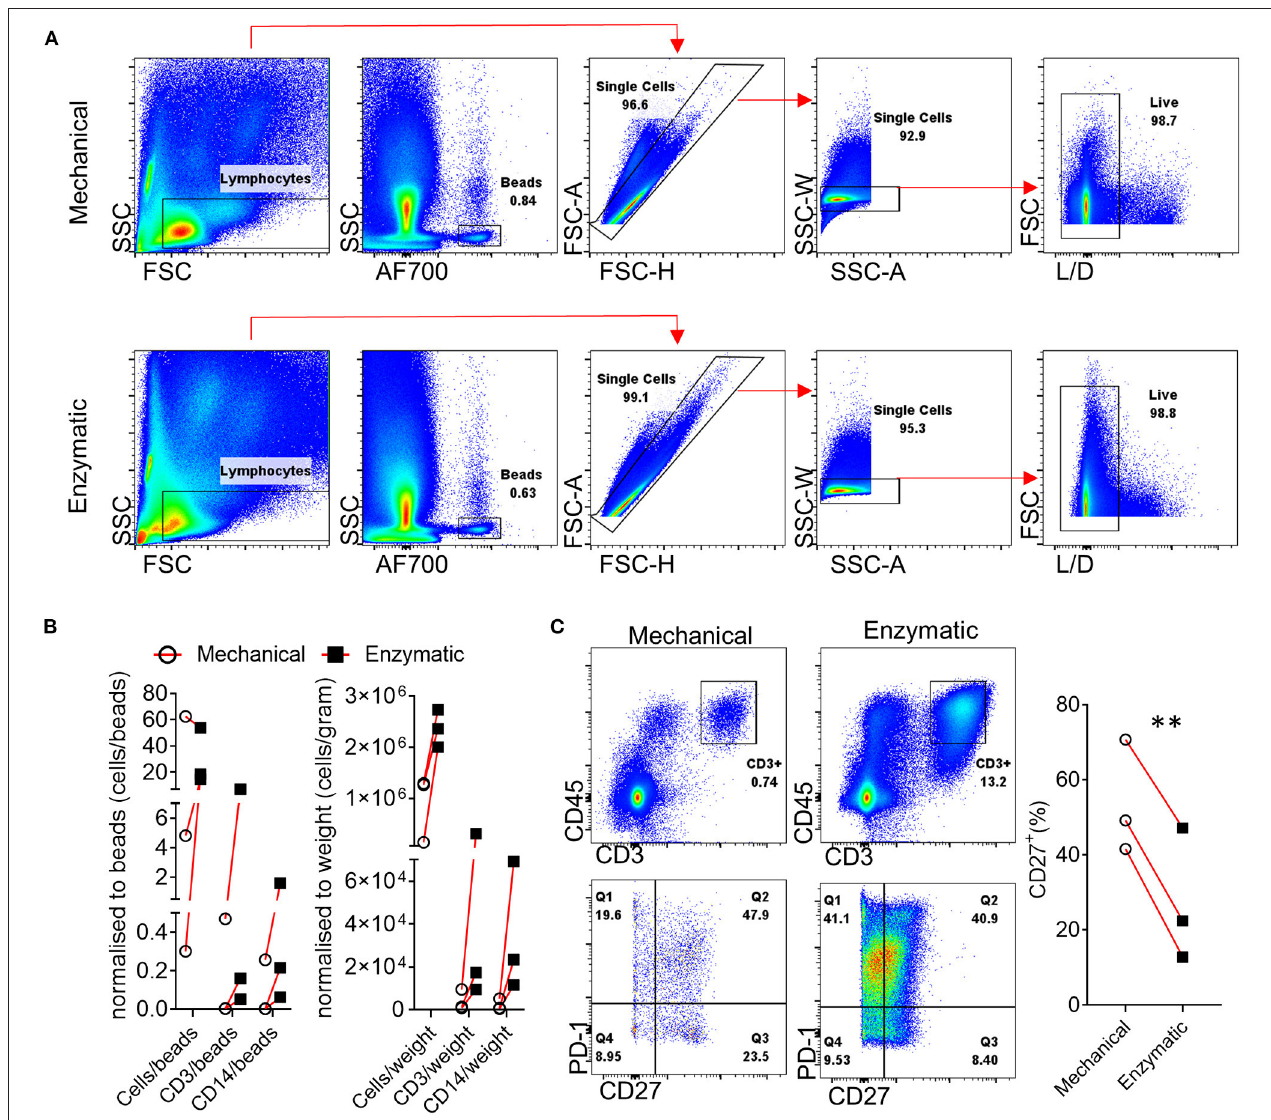
FIGURE 1 | Effect of enzymatic digestion of synovial tissue biopsies on cell and marker recovery. (A) Representative flow cytometric analysis and gating strategy followed for paired enzymatic or mechanical synovial biopsy dissociation for the generation of a single cell suspension ( n = 3). (B) Normalization of recovered, following enzymatic or mechanical digestion of paired synovial biopsies, CD3 + and CD14 + cells expressed as cells/counting beads or cells/weigh of synovial tissue. (C) Flow cytometric analysis of T cell CD27 expression following enzymatic or mechanical dissociation of paired synovial biopsies. Paired (same donor) synovial biopsies are shown, symbols indicate independent samples n = 3. Paired Students T -test was used for statistical analysis (** p = 0.003), p -values < 0.05 were considered